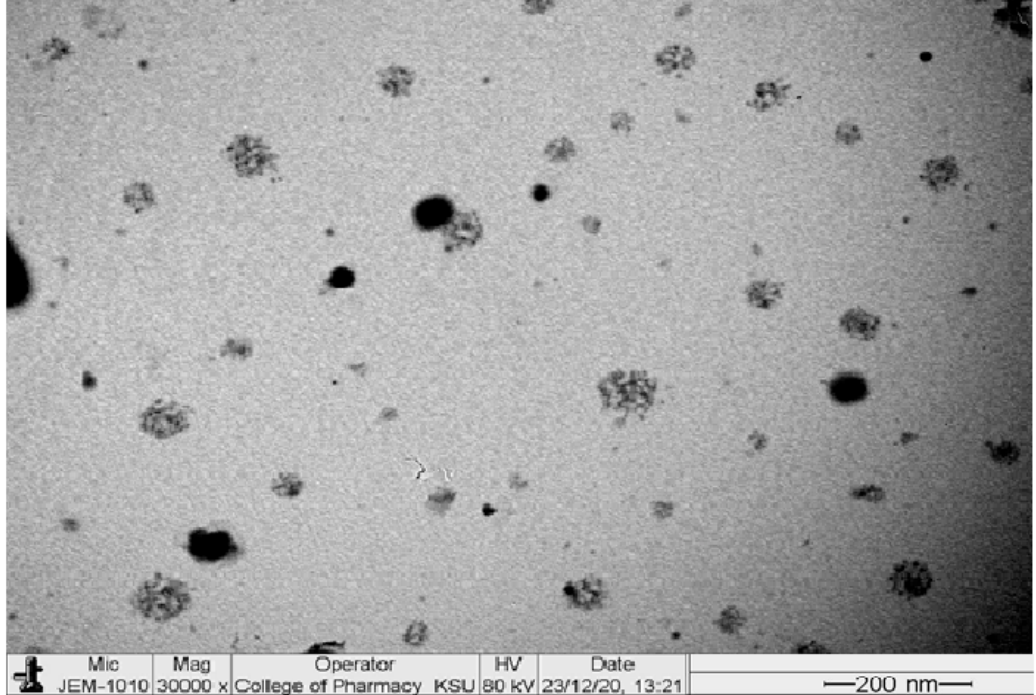
Figure 5. TEM image of the optimum formula.